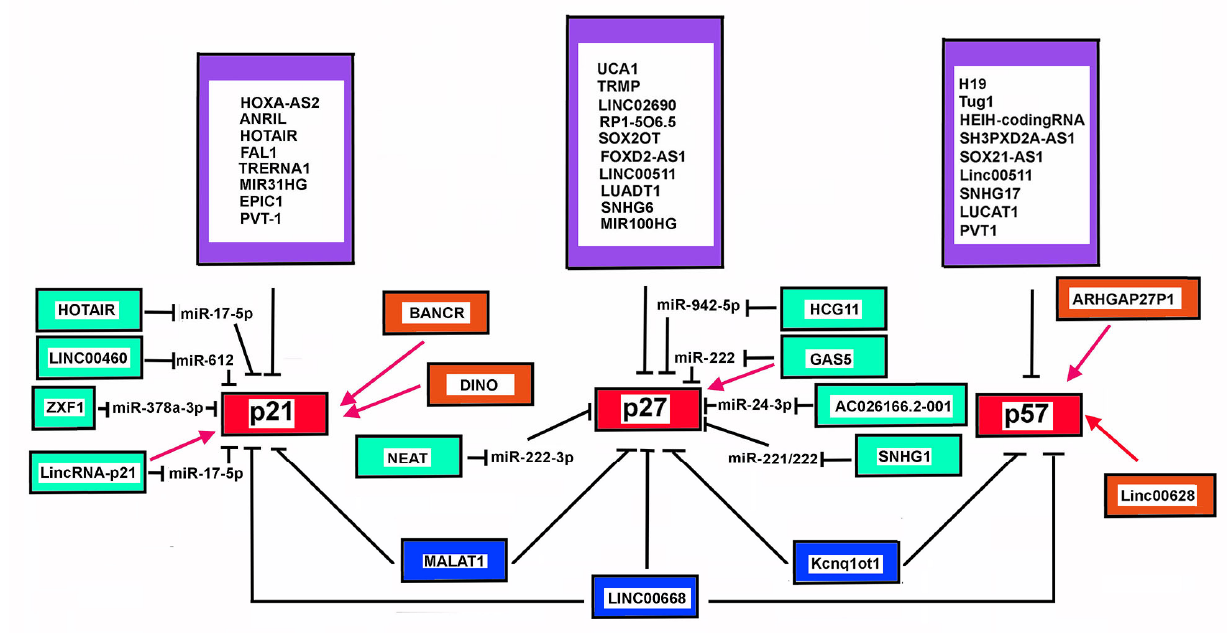
Figure 3. Model diagram of lncRNAs controlling p21 Cip1/Waf1 , p27 Kip1 , and p57 Kip2 levels. The figure summarizes the lncRNAs affecting p21 Cip1/Waf1 (p21), p27 Kip1 (p27), and p57 Kip2 (p57) cellular contents.